Question: What caption would you write for this figure?
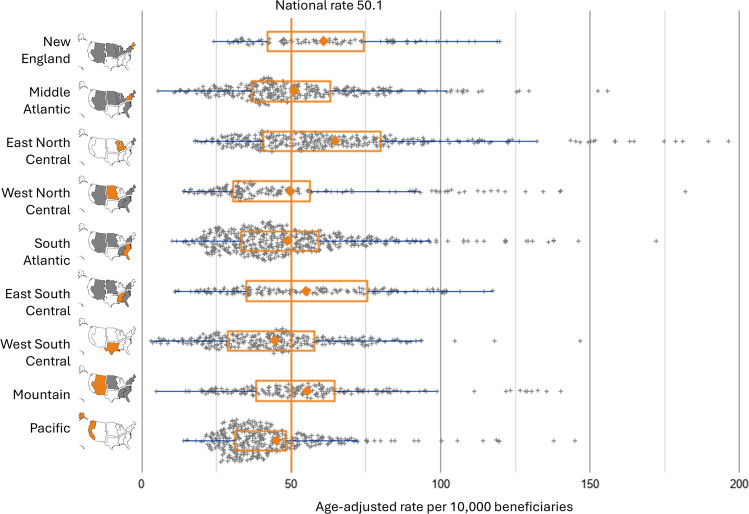
Answer: US Census Division distribution of Public Use Microdata Area (PUMA) polysomnography rates per 10,000 person-years, Medicaid beneficiaries ages 0–18 years, 2017–2019. + = one Public Use Microdata Area. Divisions shown in gray on maps are not statistically significantly different at the 0.05 level